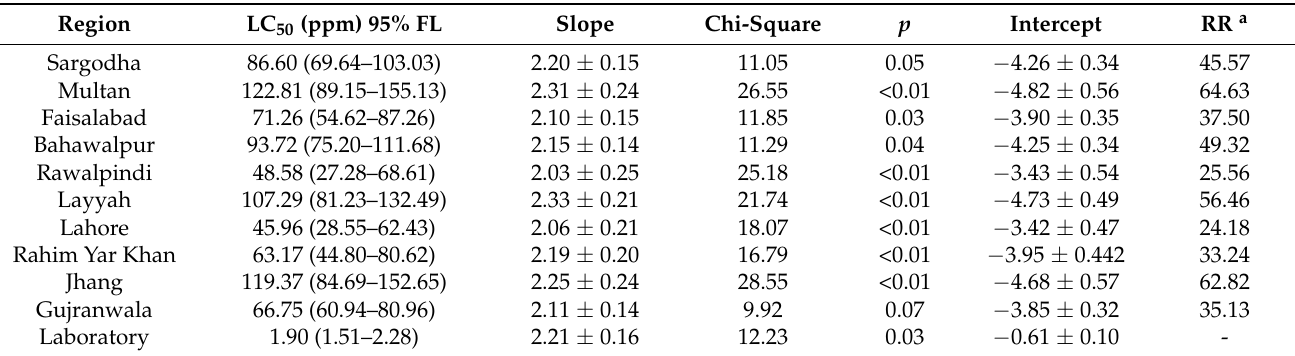
Table 2. Probit analysis of mortality for 10 field-collected populations and a laboratory-susceptible population of Sitophilus granarius adults after 20 h of exposure to phosphine. In all cases DF = 5. Region LC 50 (ppm) 95% FL Slope Chi-Square